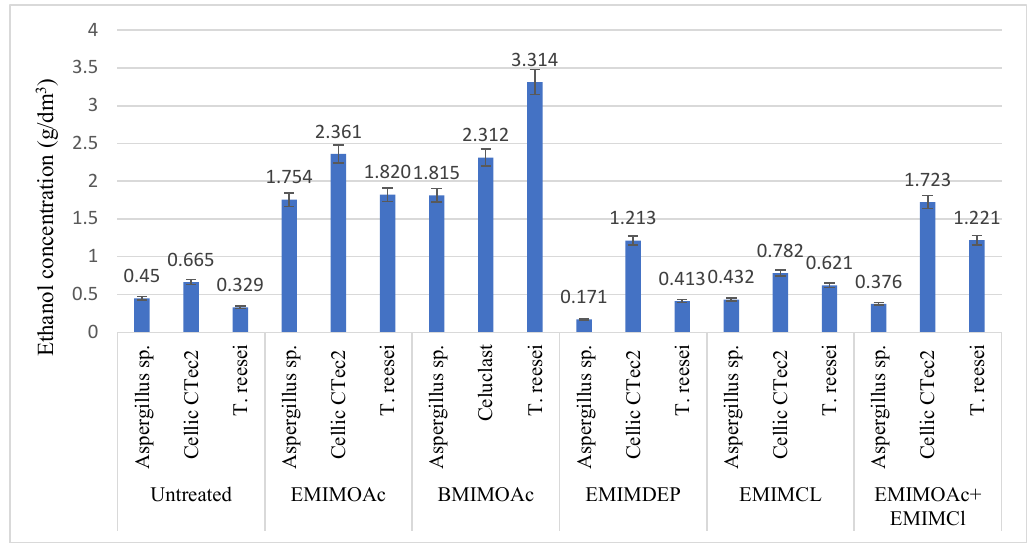
Figure 5. Ethanol content after 96 h alcoholic fermentation of untreated buckwheat straw samples and samples treated with ionic liquids.